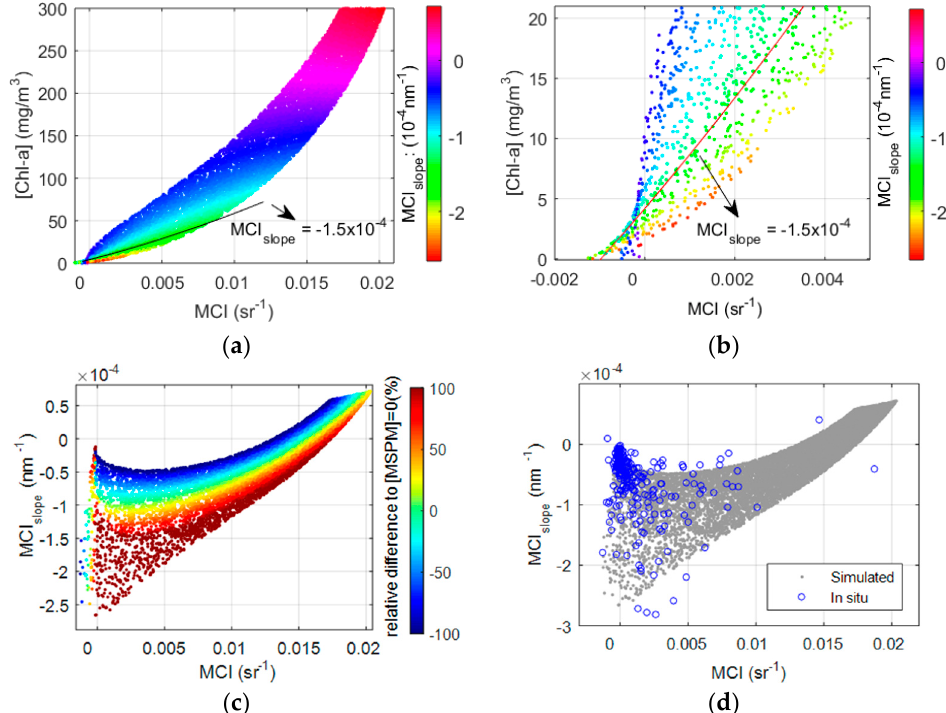
Figure 6. ( a ) The variability of the MCI slope in the relationship between [Chl-a] and MCI and ( b ) the same variability of the MCI slope in the relationship between [Chl-a] and MCI expanded to show in detail [Chl-a] < 20 mg / m 3 . ( c ) The distribution of the [Chl-a] residual relative to derived [Chl-a] at [MSPM] = 0, in the [MCI, MCI slope ] space, and ( d ) in situ derived MCI and MCI slope superimposed over simulated values.